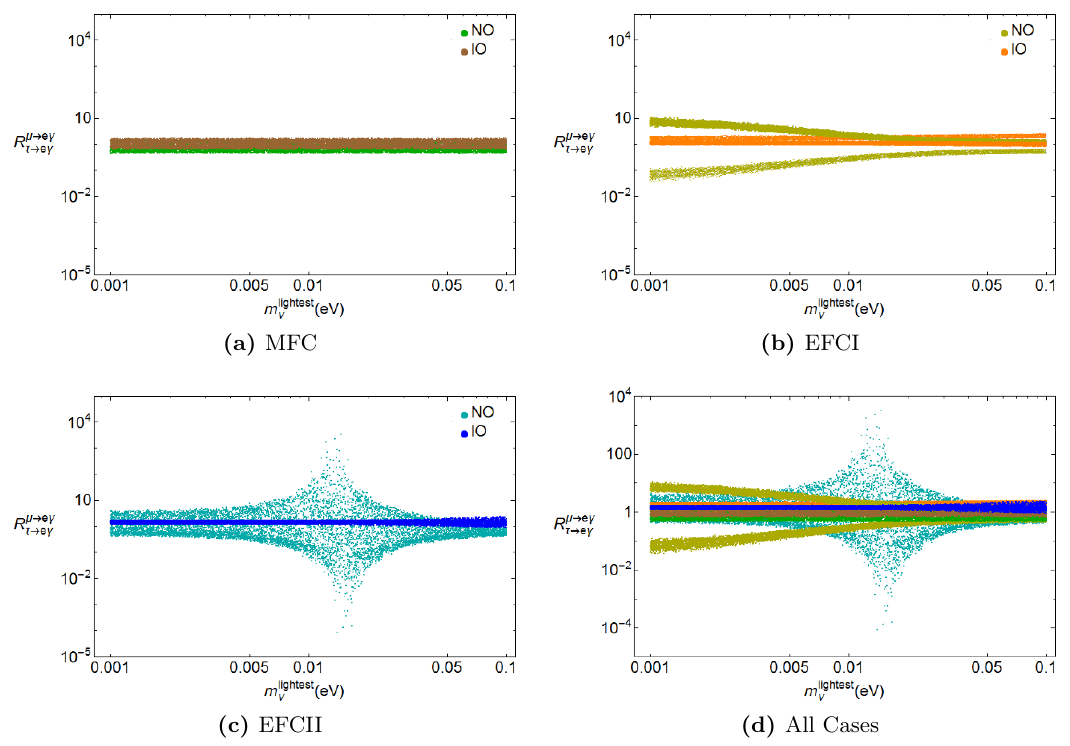
Figure 3. R (cid:22) ! e(cid:13) for the MFC, EFCI and EFCII from upper left to lower left. Lower right reports (cid:28) ! e(cid:13) the previous plots altogether. Colour codes can be read directly on each